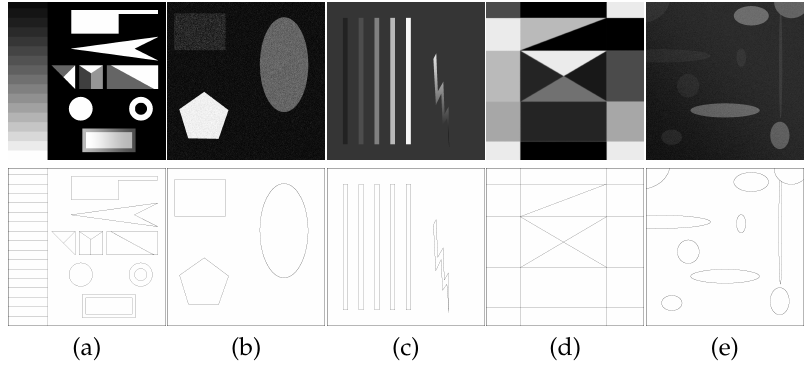
Figure 6. Synthetic gray-scale test images ( a – e